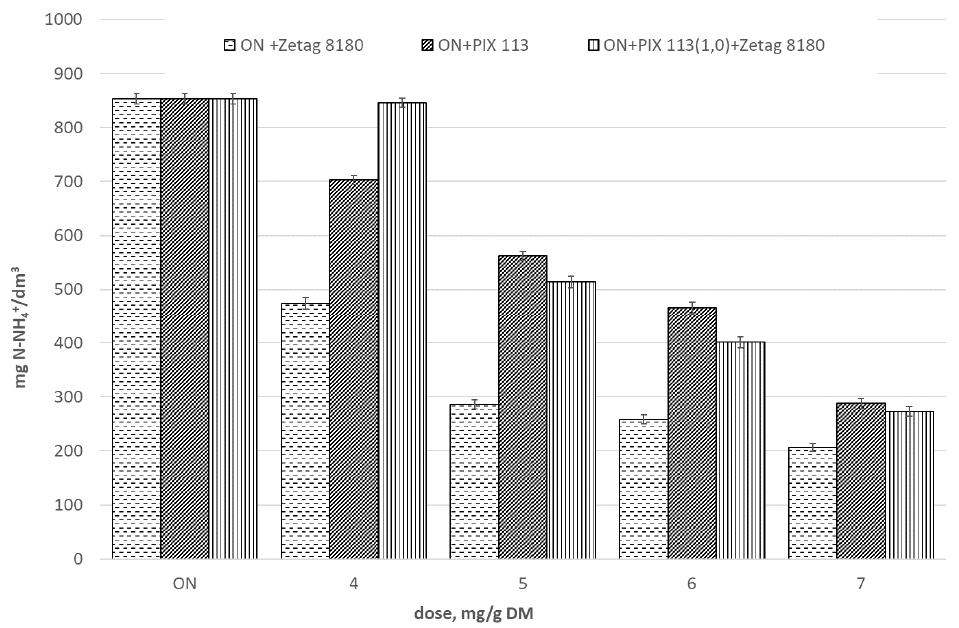
Figure 10. Ammoniacal nitrogen changes in filtrate after sludge dewatering. Sludge sonicated (A 1 = 15.25 µm) and prepared with selected chemical reagents.